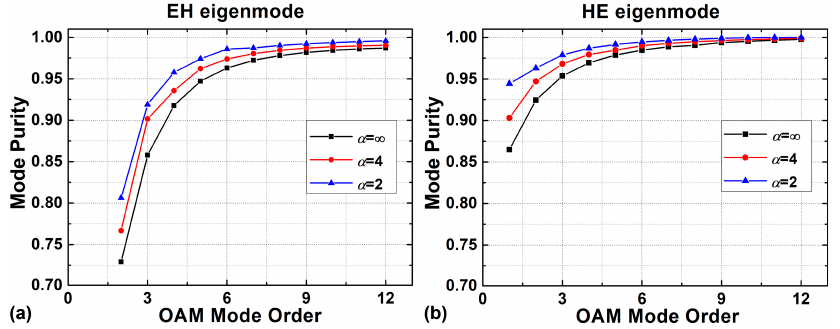
Figure 7. Purity of the ( a ) EH-composed and ( b ) HE-composed OAM modes with different shape factors.